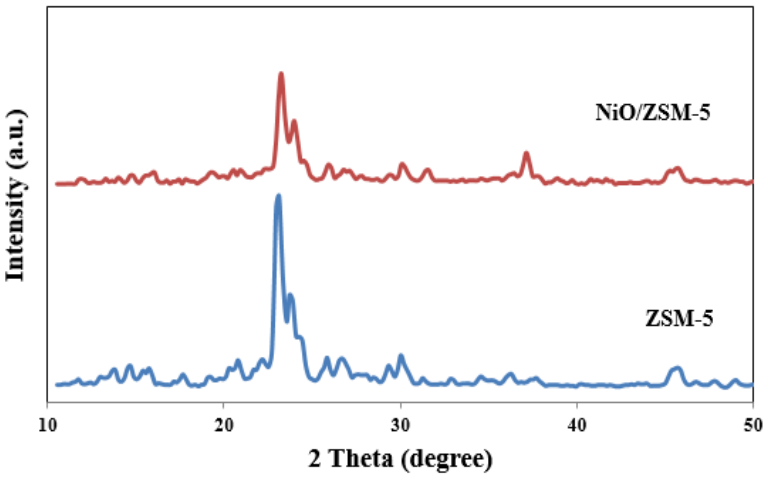
Fig. 1. XRD pattern of Nio/ZSM-5